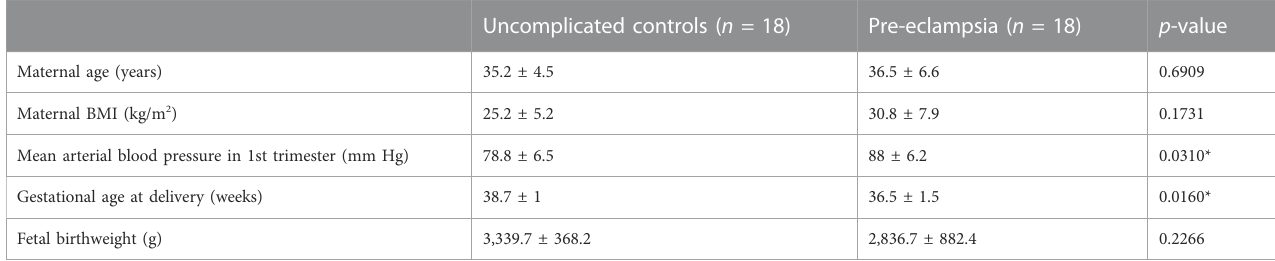
TABLE 1 Maternal clinical characteristics for all control and patient mothers enrolled in the current study. Mean ± SD. Mean Arterial blood pressure was calculated as MAP = (2 × diastolic) +